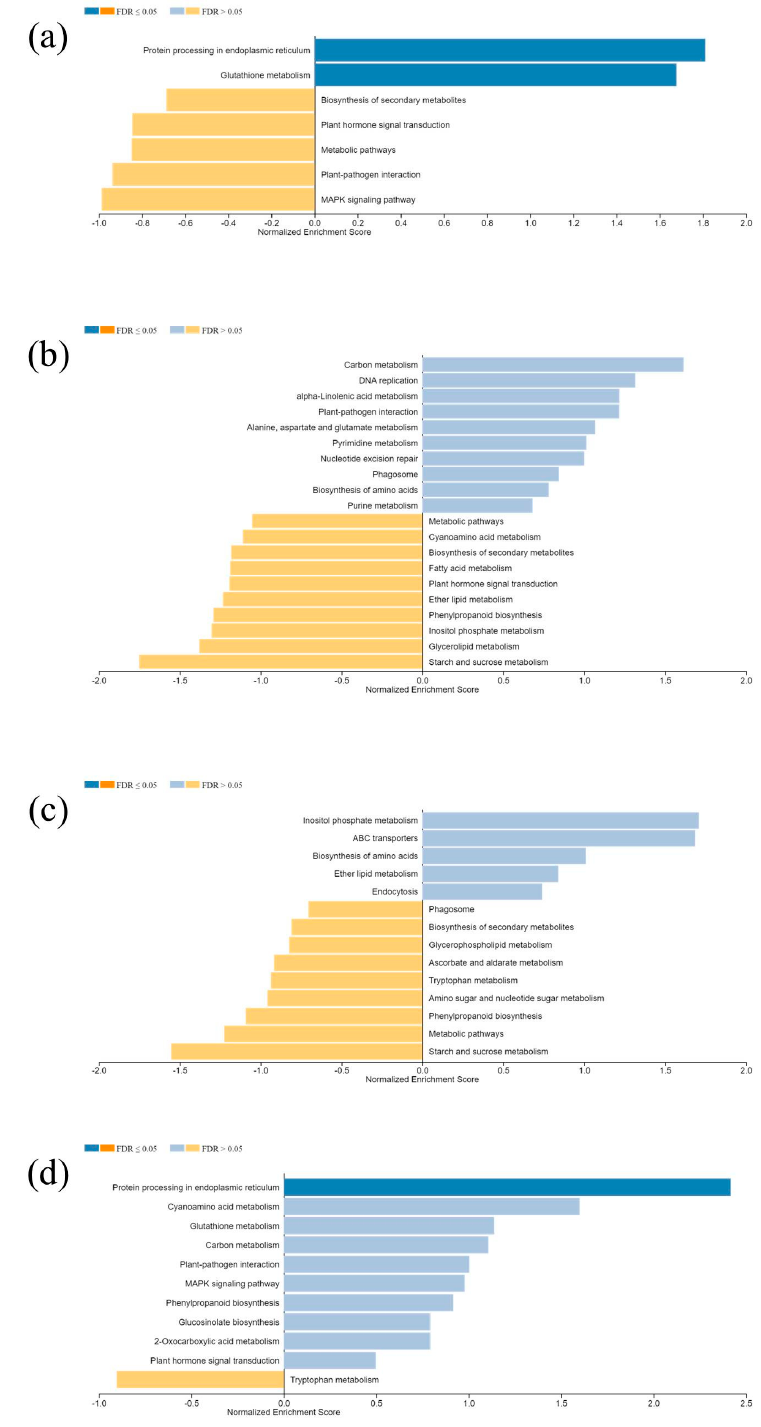
Figure 7. KEGG pathway enrichment analysis. ( a , b ) Clivus; ( c , d ),